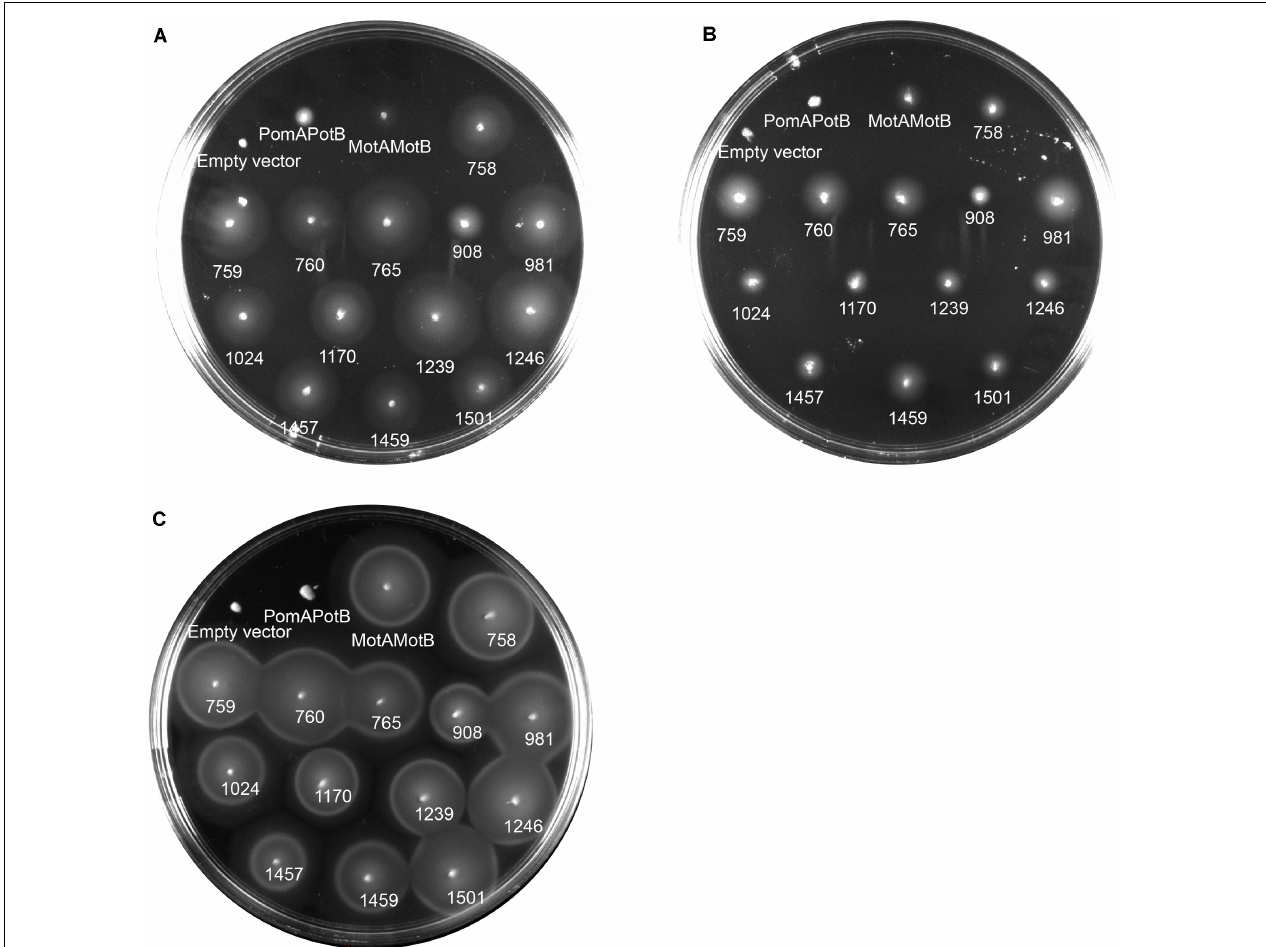
FIGURE 4 | Ion dependency of MotB-ASRs. Characterizing ion dependency of motile MotB-ASRs in the presence of Na + control (PomAPotB) and H + control (MotAMotB) on minimal swim plates (with/without NaCl). (A) All MotB-ASRs (presented according to the respective nodes) restored motility in (cid:49) motB strain RP3087 in the presence of Na + . (B) In the absence of Na + , all the MotB-ASRs restored motility in (cid:49) motB strain RP3087. (C) All MotB-ASRs restored motility in the presence of Na + and 100 µ M of the sodium-blocker phenamil. (A,B) incubated at 30 ◦ C for 16 h, (C) at 30 ◦ C for 14 h.